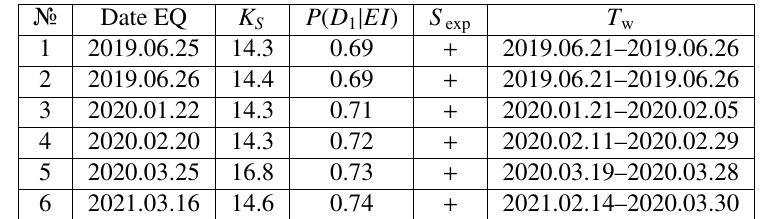
Table 3. List of predicted earthquakes with energy class K S ≥ 13 . 5 ( M ≥ 6 . 0) over period